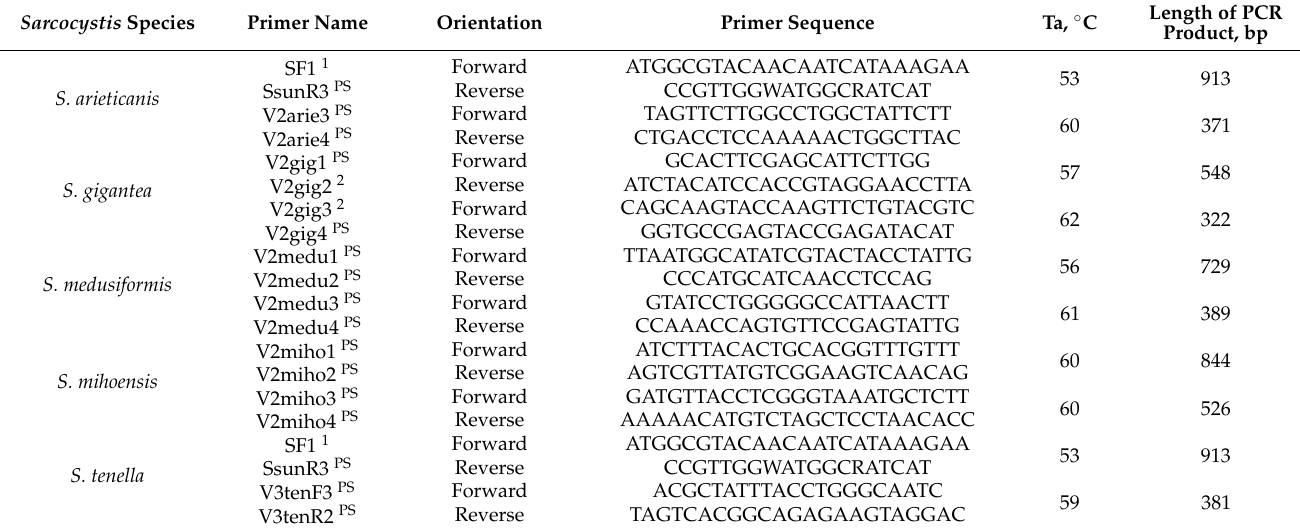
Table 1. Oligonucleotide primers used to amplify the cox1 region of Sarcocystis spp. from domestic